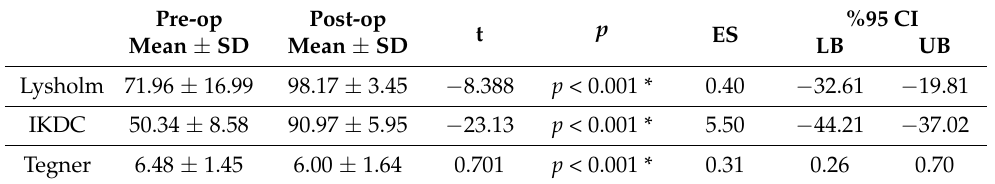
Table 2. Comparison of pre-operative and post-operative levels of Lysholm, Tegner, and IKDC scores. Pre-op Post-op